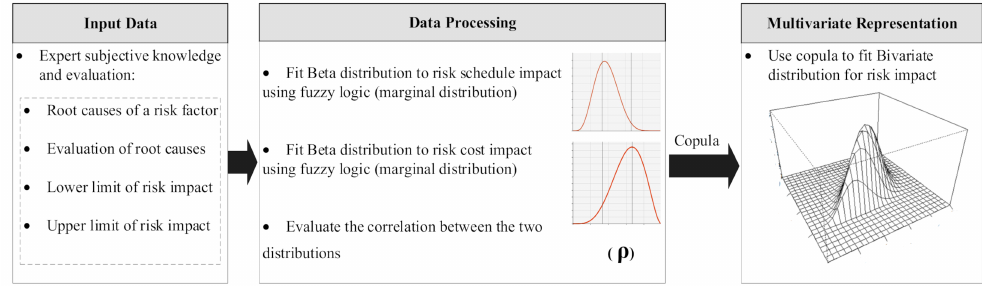
Figure 3. Research